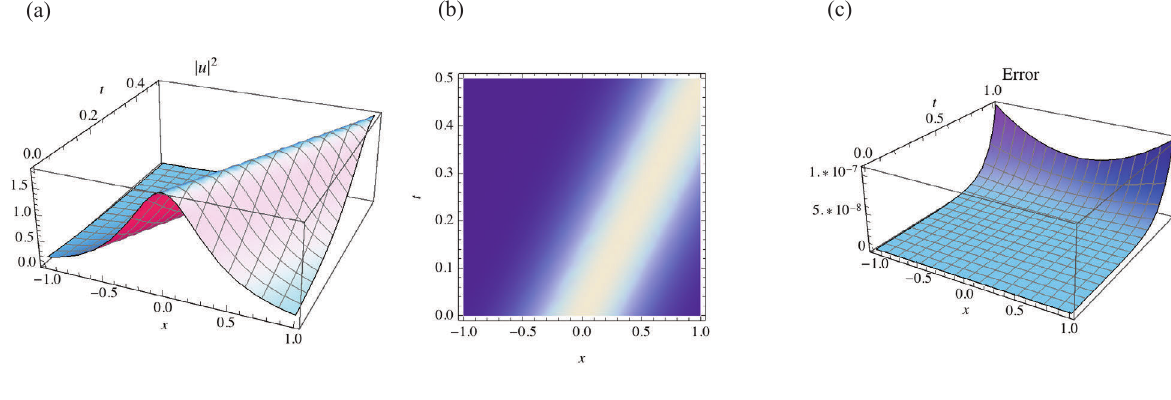
Fig. 3. Graphical representation of the results of example 3: (a) 3D bright soliton, (b) 2D density contour and (c) Absolute error with N = 14 iteration steps.